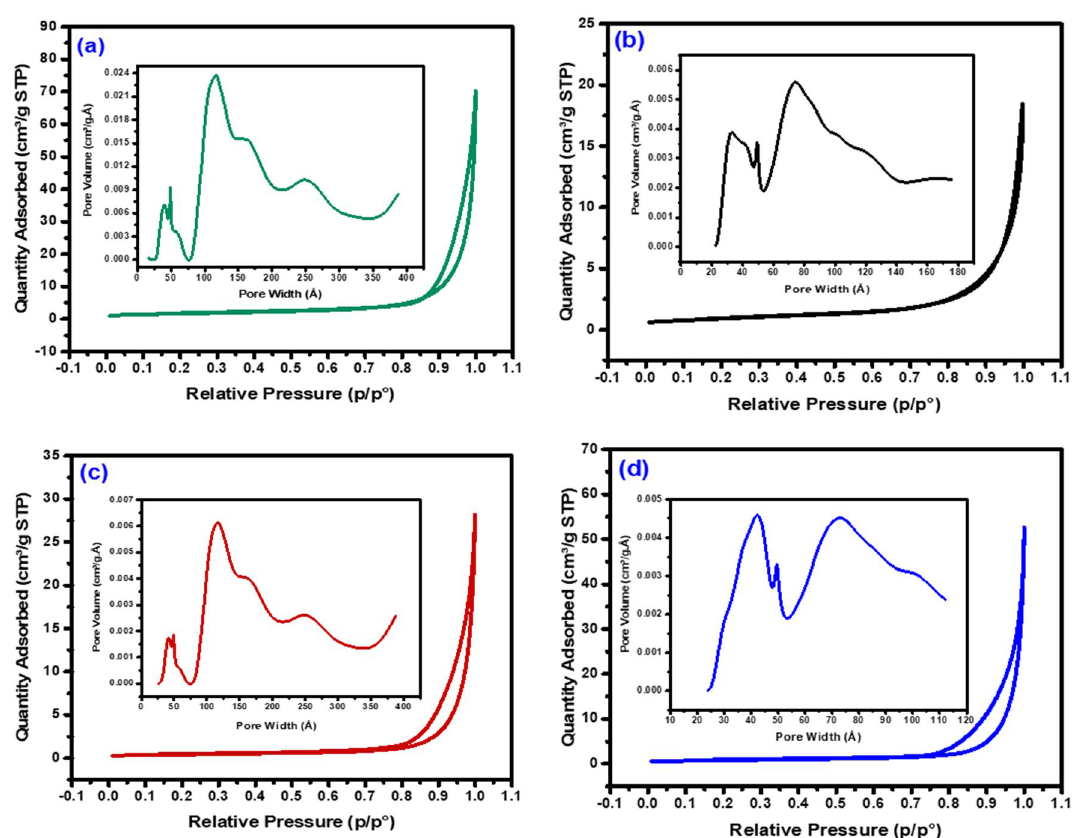
Figure 3. Nitrogen physisorption isotherms of the fresh samples: ( a ) Ni, ( b ) Ni-Co, ( c ) Ni-Fe, and ( d ) Ni-Cu.